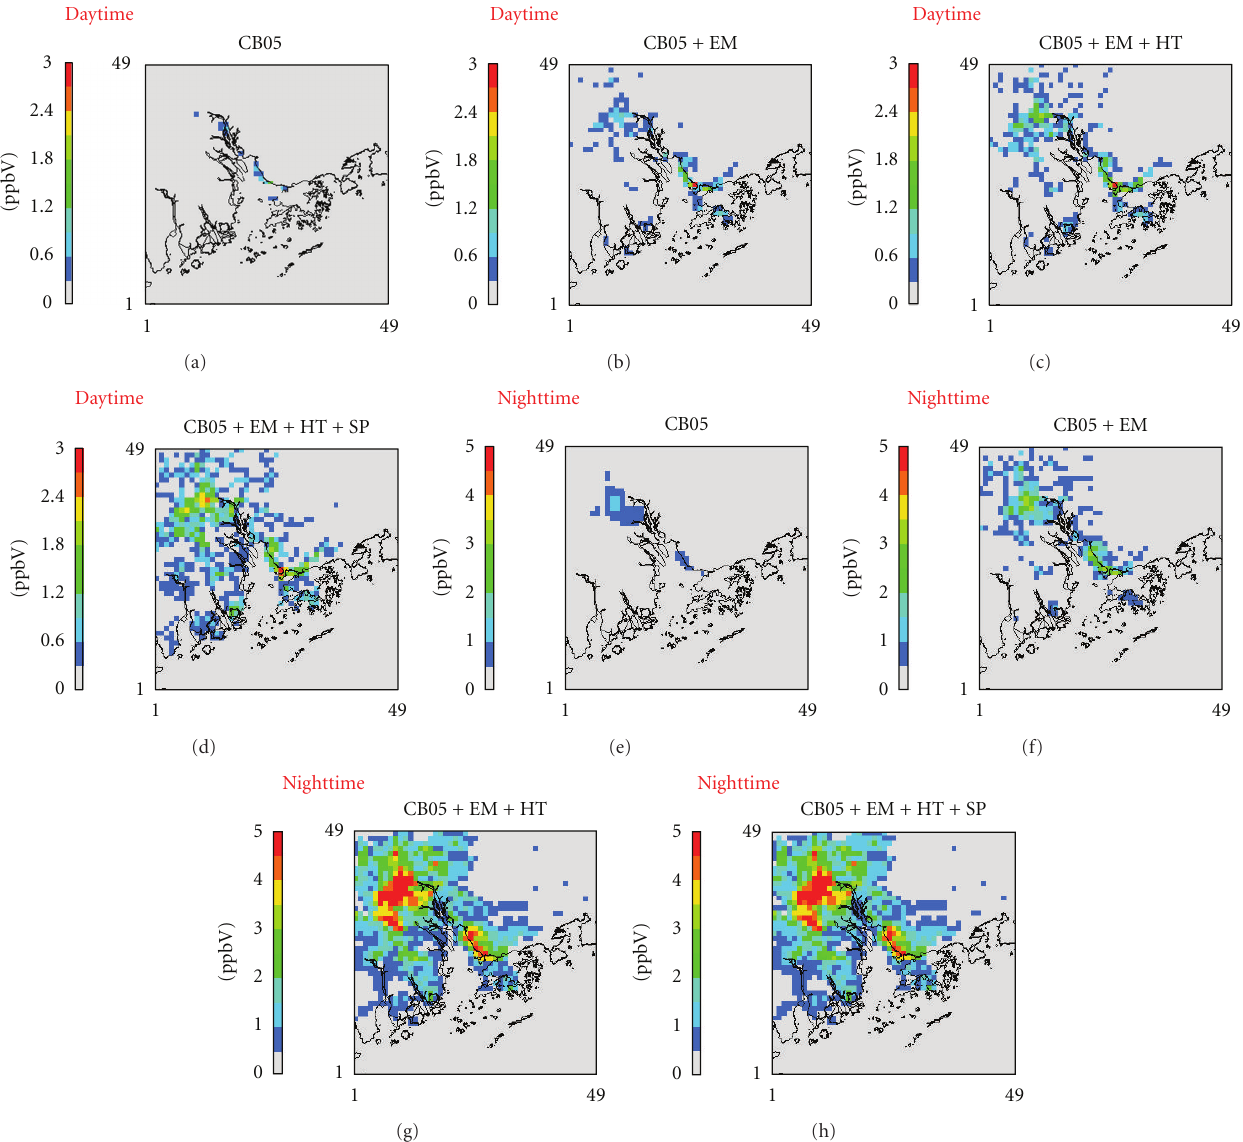
Figure 5: Spatial distribution of simulated HONO through homogeneous reactions, direct emission, heterogeneous reaction, and surface photolysis formation pathway at daytime (a–d) and nighttime